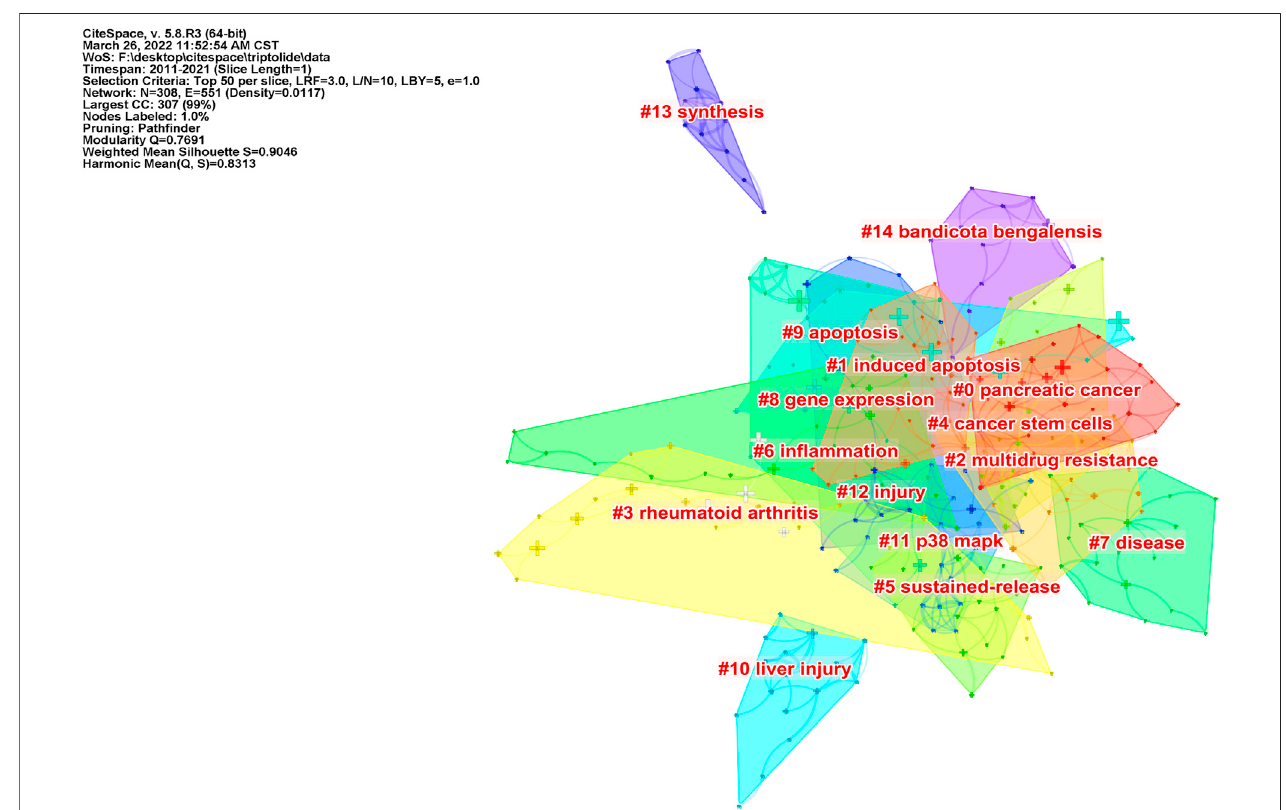
FIGURE 7 | Clustering network of triptolide literature keywords from the